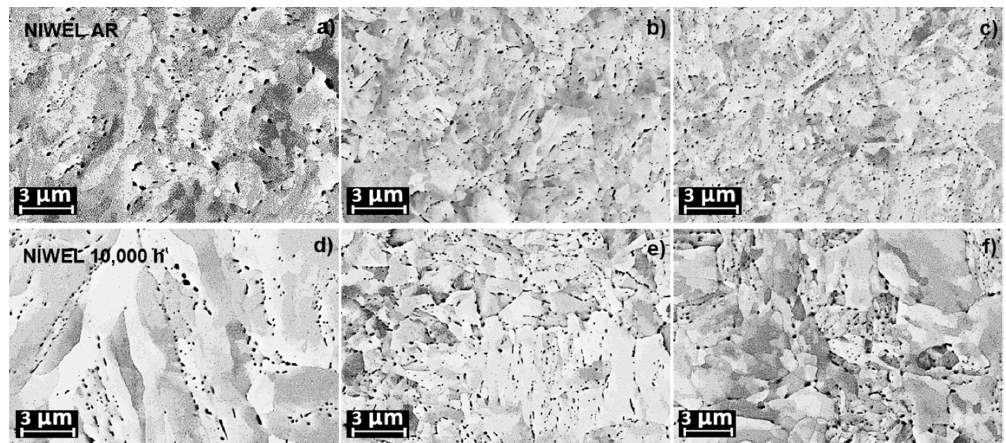
Figure 3. EBSD mapping of the microstructures in the LAS HAZ of the NIWEL 5000 h condition, at different distances from the FB. Progressive grain refining of distance from ( a ) 2500, ( b ) 1000 to ( c ) 300 μ m to FB, and grain coarsening at ( d ) 30 μ m to the FB were observed.